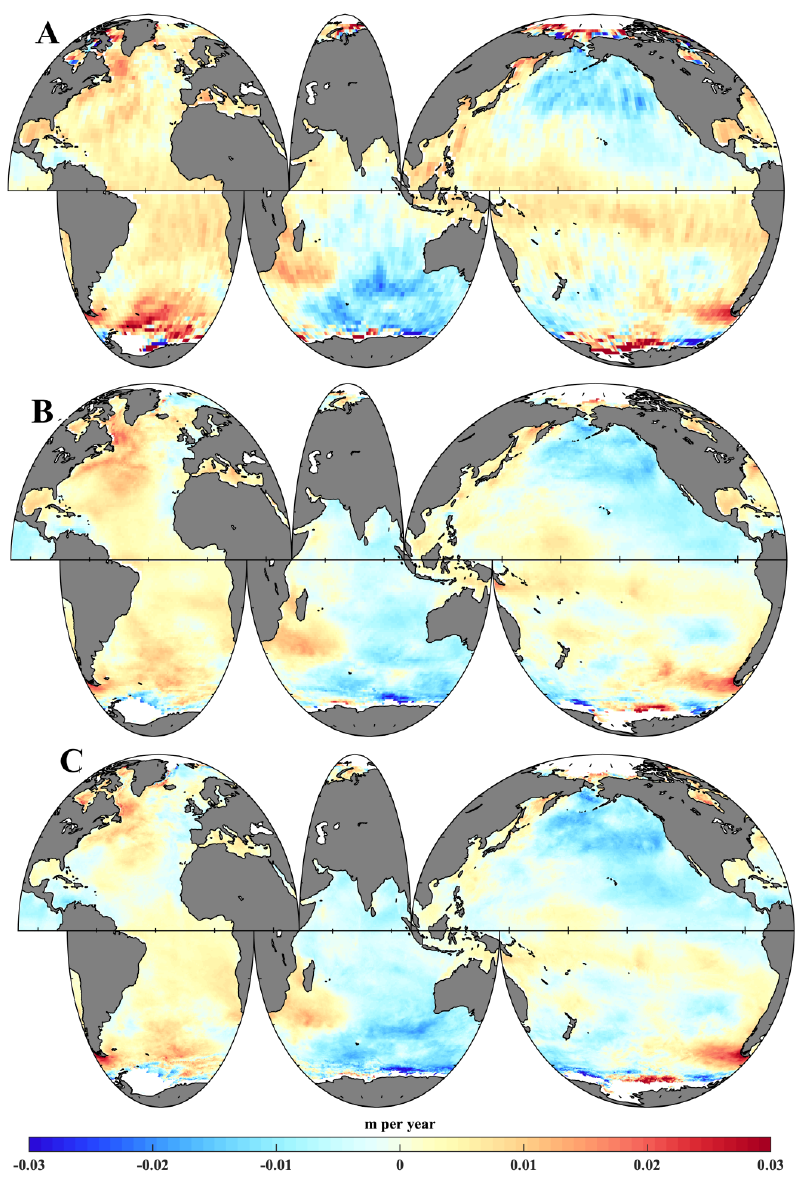
Figure A1. Spatial distributions of global annual SWH trends for 1999–2013 from ( A ) altimeter, ( B ) ERA-Interim and ( C )